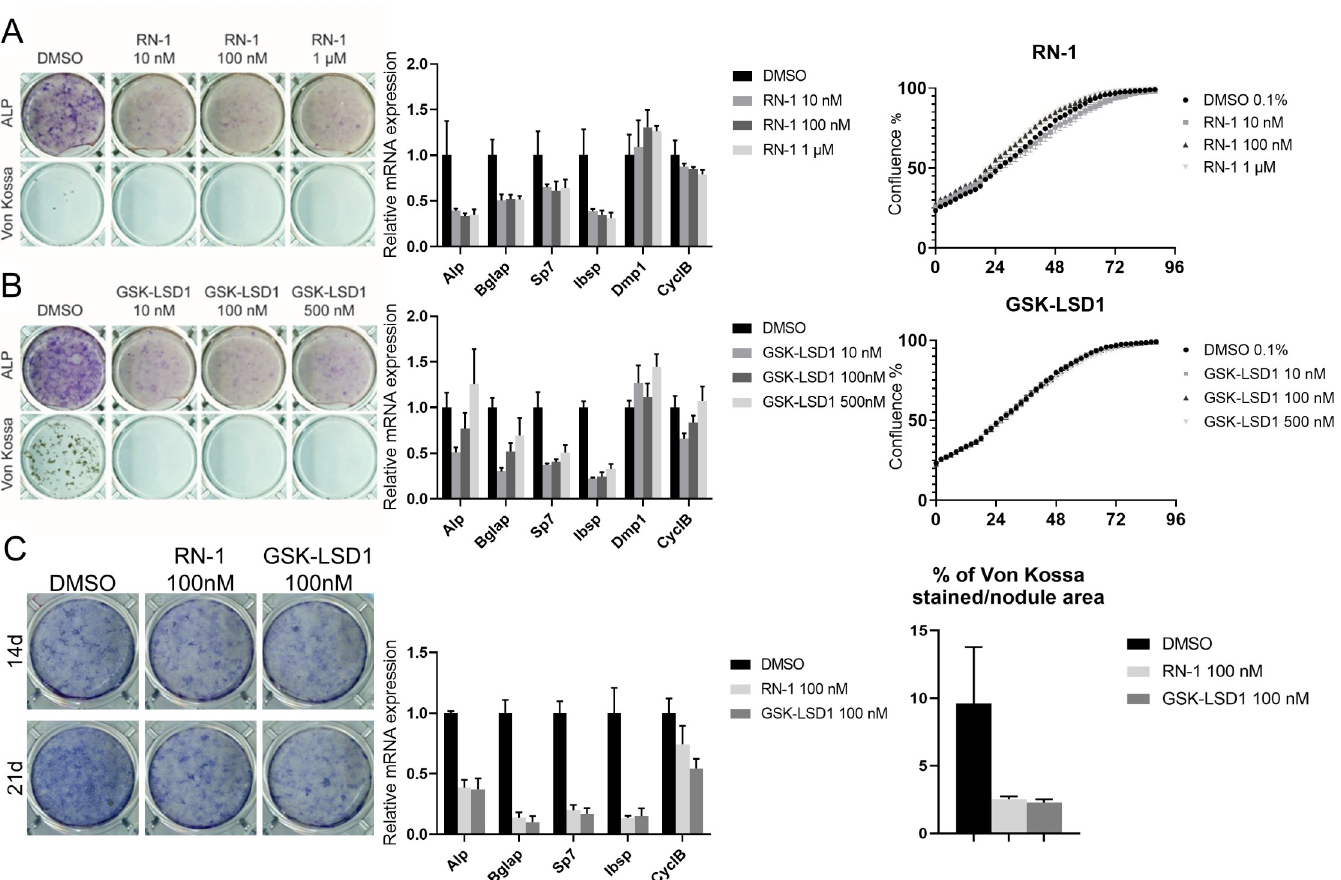
Fig 2. Lsd1 inhibition in osteoblasts. Effect of Lsd1 inhibition in MC3T3-E1 cells by RN-1 (A) and GSK-LSD1 (B) on differentiation demonstrated by ALP and Von Kossa staining of 21d differentiated cells (left), expression of osteoblast related genes in 14d differentiated cells quantitated by qPCR (middle, n = 3) and proliferation rate (right, n = 3). Effect of Lsd1 inhibition in calvarial osteoblasts by RN-1 and GSK-LSD1 (C) demonstrated by ALP staining of 21d differentiated cells (left), expression of osteoblast related genes in 14d differentiated cells quantitated by qPCR (middle, n = 3) and von Kossa stained area (right, n = 3). P-values for statistically significant differences are marked � P < 0.05, �� P < 0.01, ��� P <